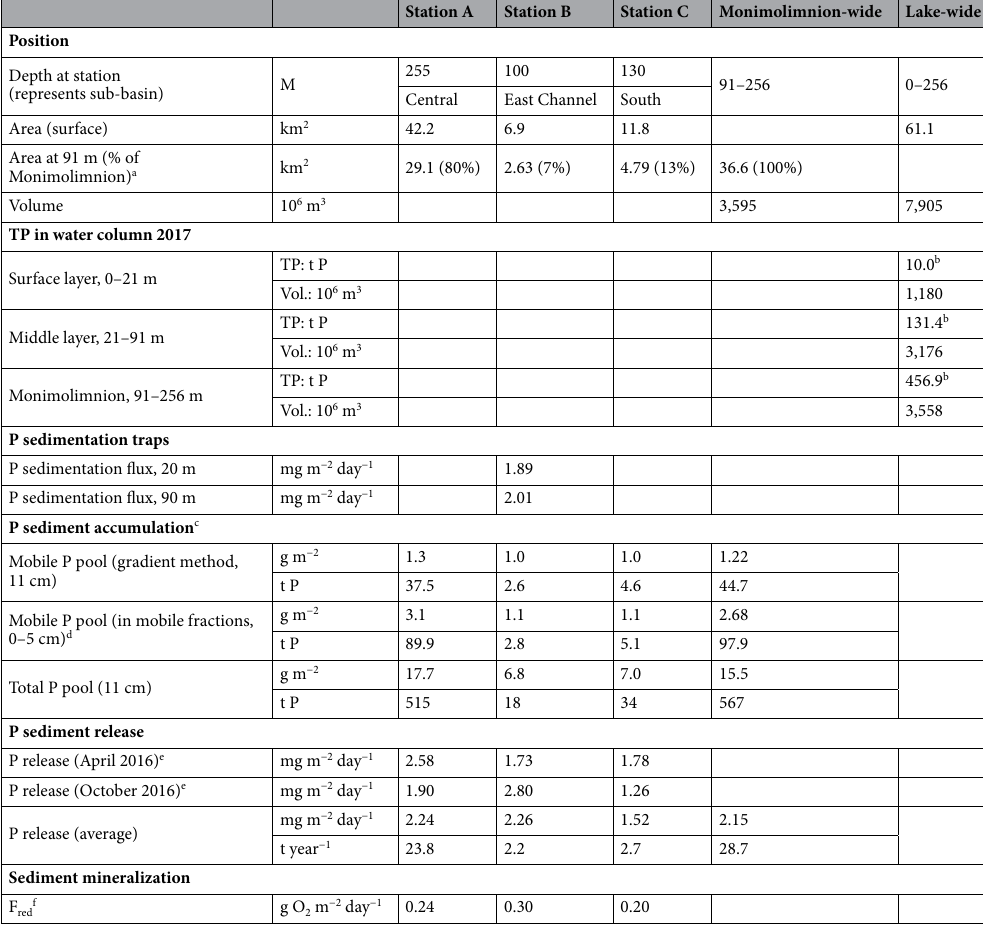
Table 1. Selected characteristics and lake-internal phosphorus (P) pools and fluxes at three measurement stations in Lake Iseo (2016–2017). a Hypsographic curves of sub basins in Supplementary Figure S1, b averages from two sampling time points, c expressed relative to area, cumulative mass profiles for all stations in the Supplementary Figure S3, d calculated according to Hupfer et al. 70 , e from porewater SRP gradients in